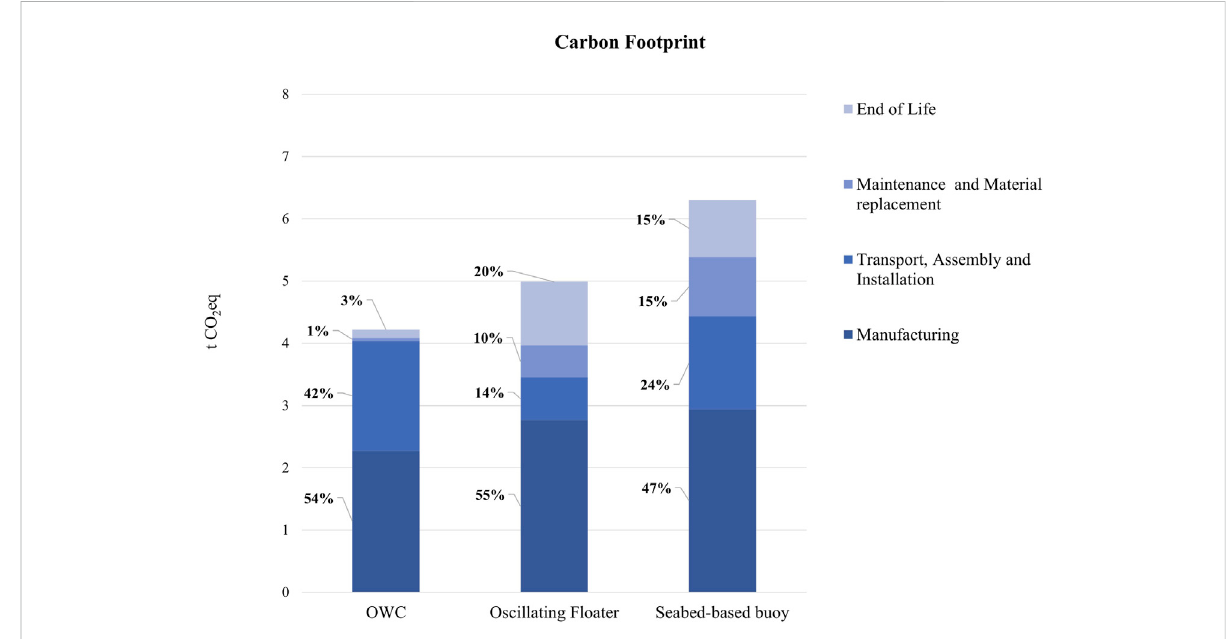
FIGURE 6 CIE values of the WEC systems available in the literature (grey columns) and results obtained from the present study (colored columns).